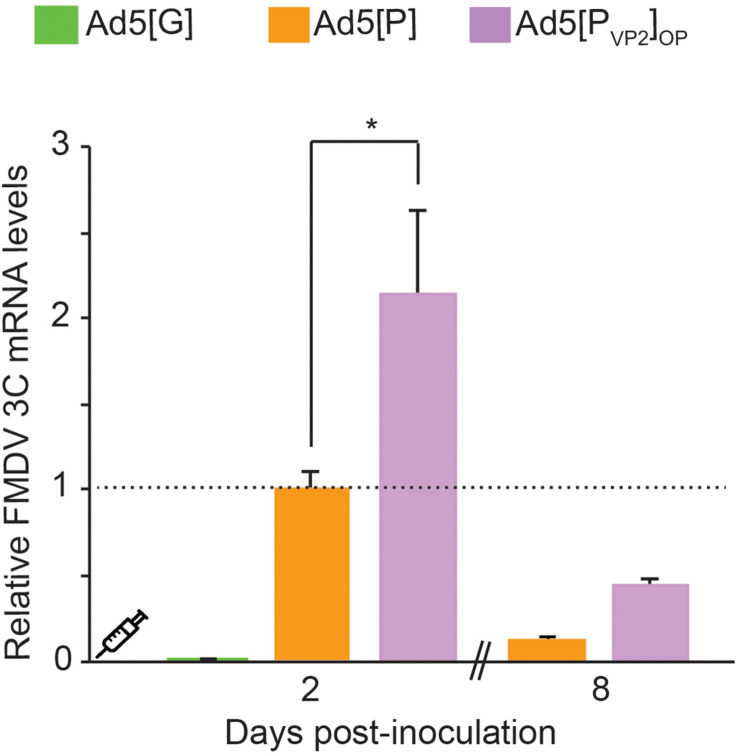
Comparative detection of foot-and-mouth disease virus (FMDV) transcripts in draining popliteal lymph nodes (dPLNs) of inoculated mice. Comparison of transcript accumulation levels in dPLNs after inoculation of BALB/cJ mice. Animals (n = 3) were inoculated i.m. with 5 × 108 PFU of Ad5[G], Ad5[P], or Ad5[PVP2]OP. Total RNA was extracted from dPLNs at 2 and 8 dpi, respectively, and a fragment of the FMDV 3Cpro open reading frame (ORF) and the GAPDH ORF were amplified by RT-qPCR. For each experimental group, the FMDV 3Cpro transcript level relative to the Ad5[P] group was calculated by using the 2− ΔΔCt equation. Data correspond to the average and standard deviation from two independent experiments. *p < 0.01 (ANOVA).